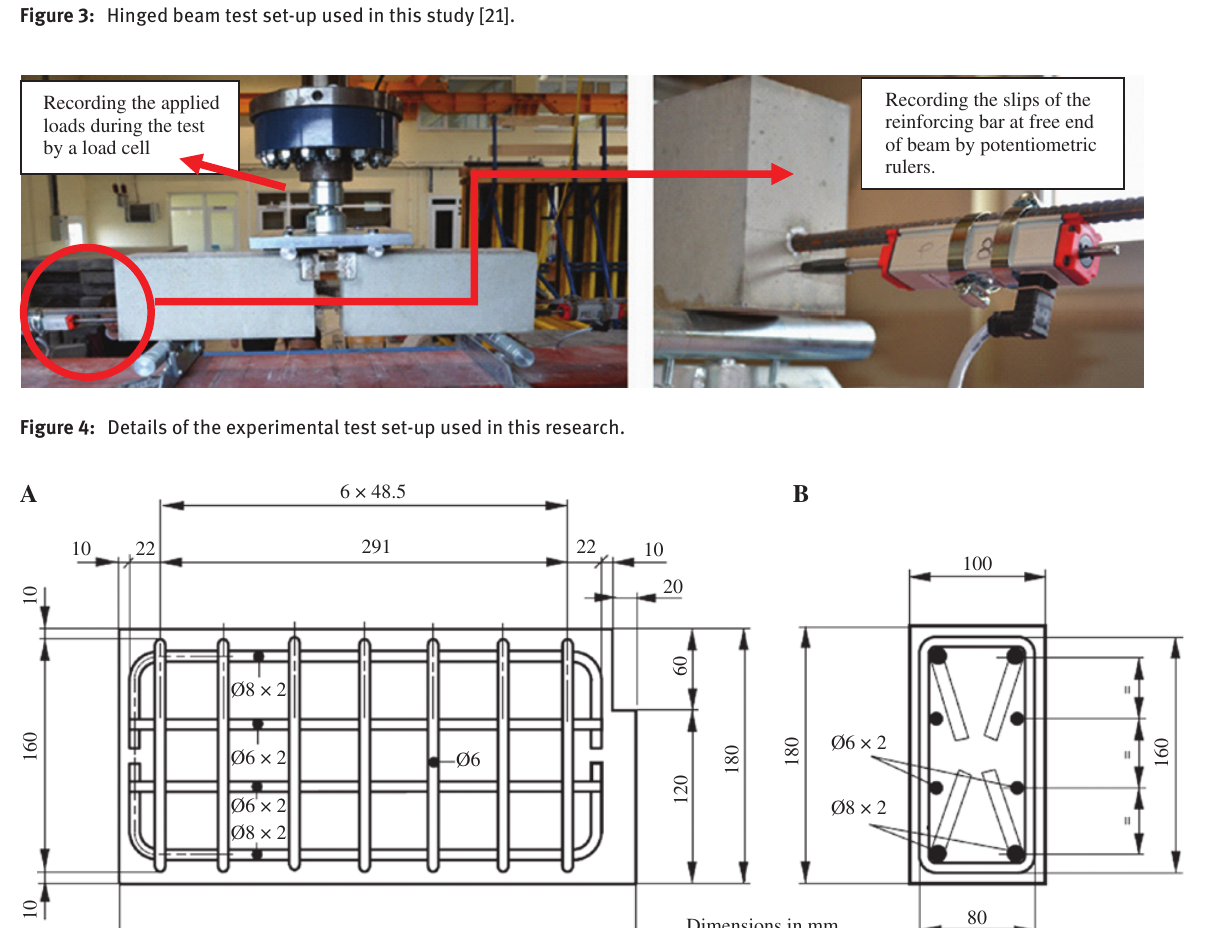
Figure 3: Hinged beam test set-up used in this study